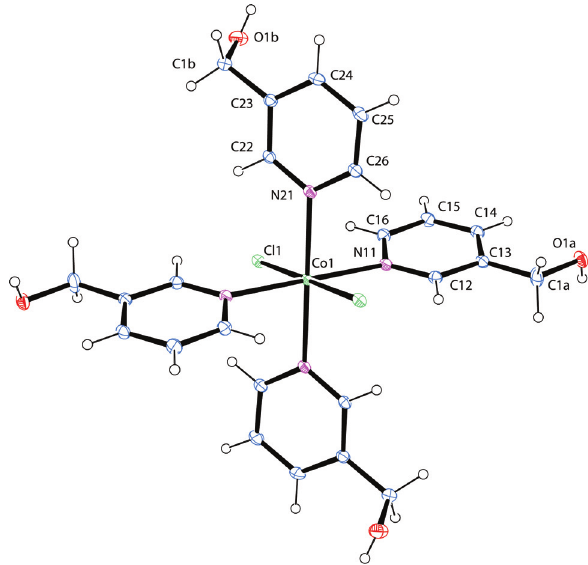
Figure 3. Left: Superposition of CoCl (black) and 2 (red). Center: Superposition of CoCl les in 1 (black) and 3 (blue). Right: Superposition of CoCl molecules in 2 (red) and 3 (blue). Hydrogen atoms were omitted for clarity.